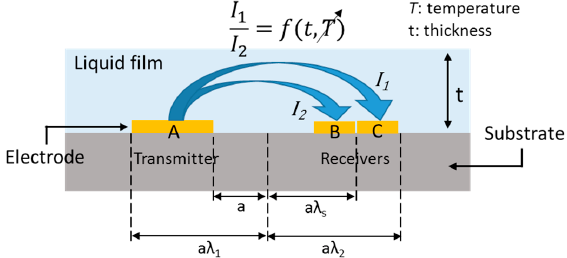
Figure 1. Principle of the three-electrode conductance method [9].